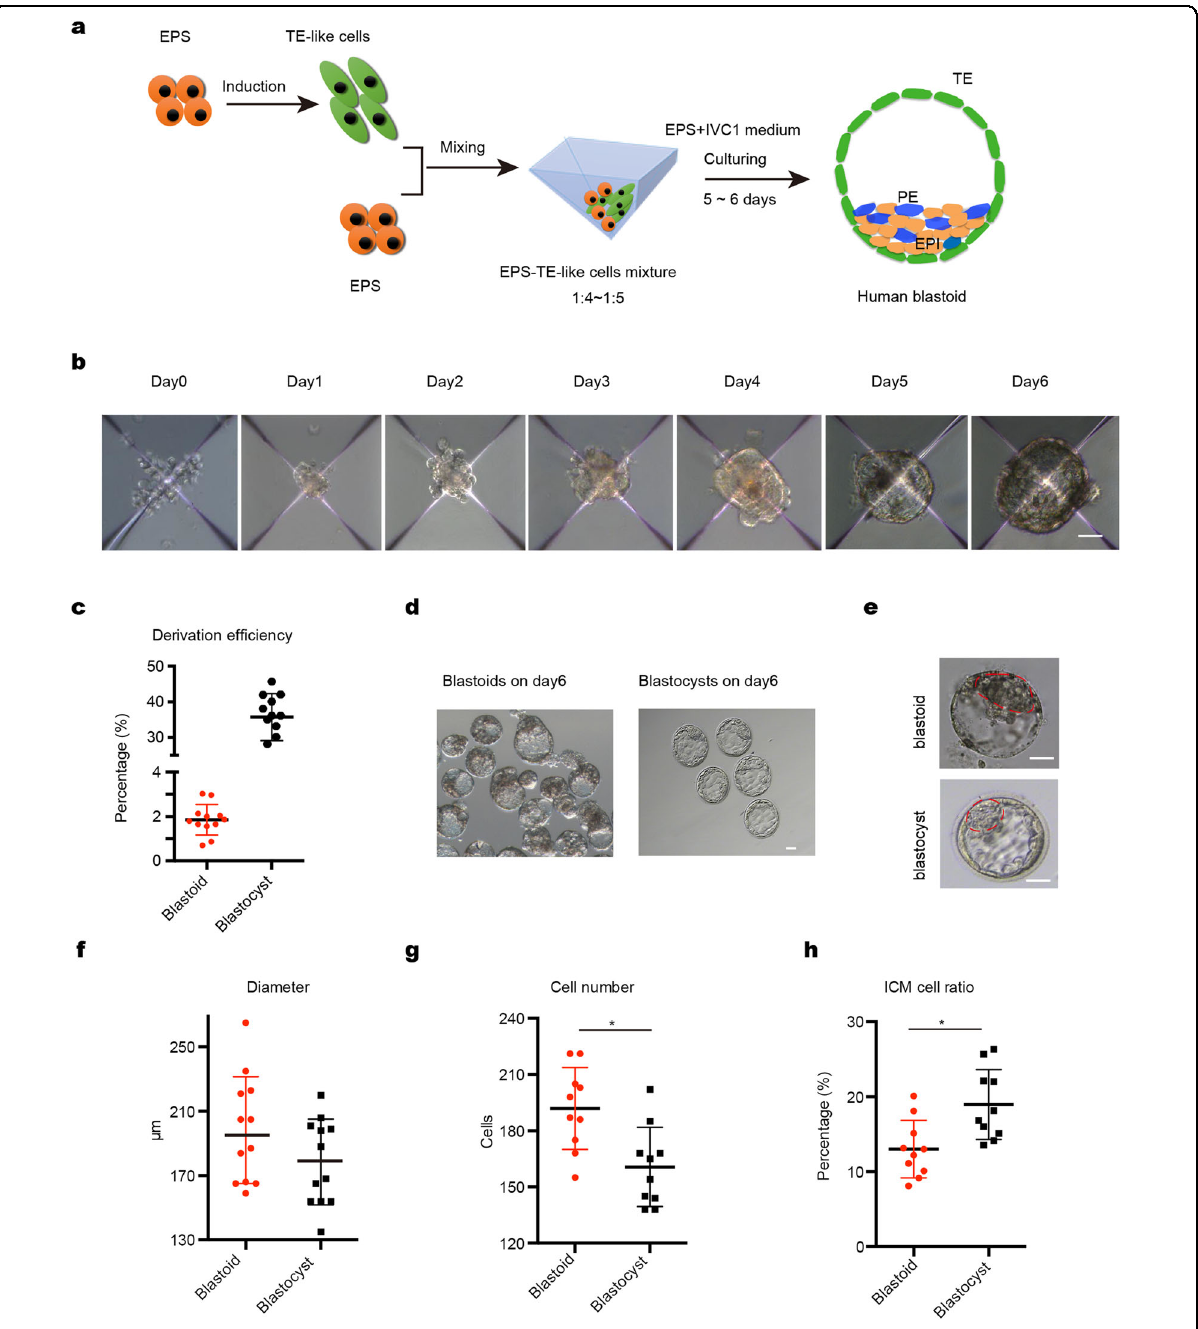
Fig. 1 Induction of human blastoids under 3D two-step condition. a Schematic of human blastoid formation. EPS cells were fi rstly induced to TE- like cells, and then TE-like cells were mixed with EPS cells and seeded together to AgreeWell on day 0. The aggregates further differentiated and organized into a human EPS-blastoid. b Phase-contrast images of human aggregates in the indicated days showing the formation of human blastoids from day 0 to day 6. Scale bar = 5 μ m. c Derivation ef fi ciency of human blastoids is about 1.9% that signi fi cantly lower than the developmental ef fi ciency of human blastocysts. d Phase-contrast image of human blastoids on day 6, Scale bar = 50 μ m. e Phase-contrast image of human EPS-blastoid (upper) and human blastocyst (lower). Red line indicated inner cell mass (ICM) of the structure and the outer layer cells represented trophoblast cells (TE). Scale bar = 50 μ m. f – h Mean diameter ( f ), total cell number ( g ), and ICM cell ratio ( h ) were quanti fi ed between human EPS-blastoids and blastocyst. n = 30 EPS-blastoids, n = 30 blastocyst. Data in c , data are means ± SD ( n = 12 blastoids). ** P < 0.001. Data in e , data are means ± SD ( n = 12 blastoids). P > 0.05. Data in f and g , data are means ± SD ( n = 12 blastoids). * P < 0.05. Data in h , data are numbers ( n = 40 blastoids, 40 blastocysts), ** P <